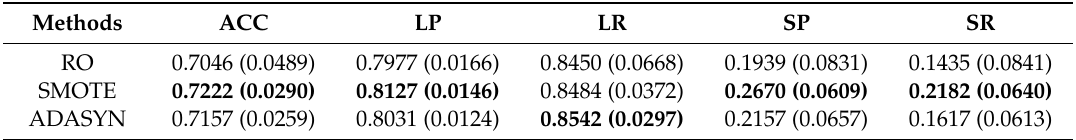
Table 3. Performance of di ff erent oversampling